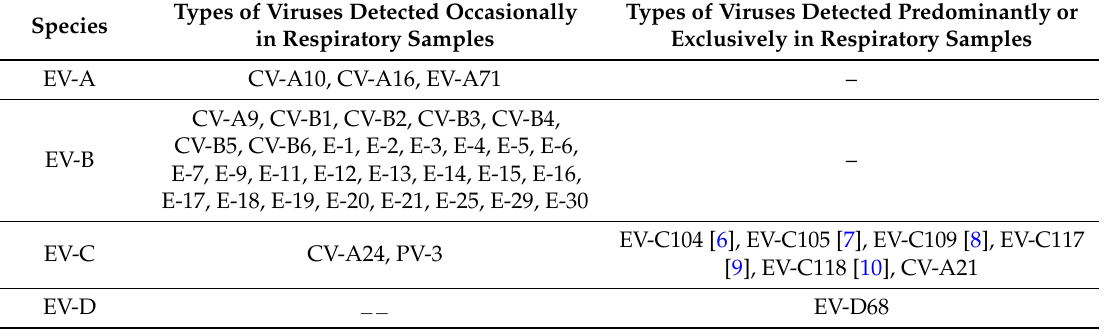
Table 1. Non-Rhinovirus (RV) Enteroviruses (EVs) associated with respiratory diseases.